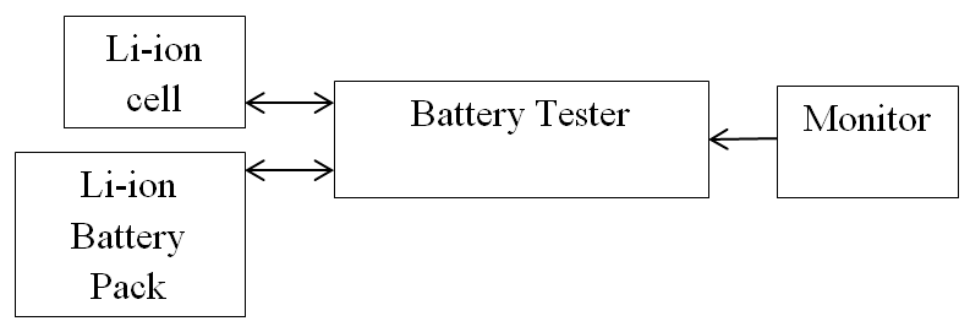
Figure 15. UDDS and DST test setup .